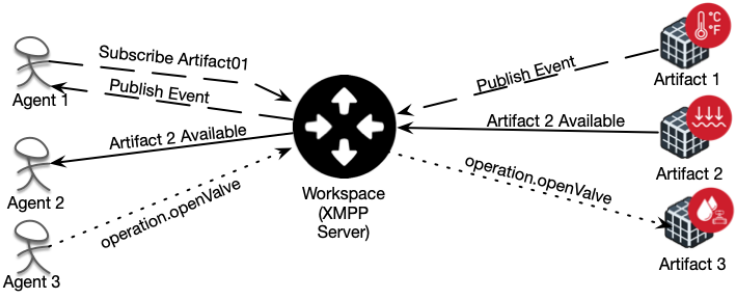
Figure 6. Examples of interactions between IoT artifacts and agents in